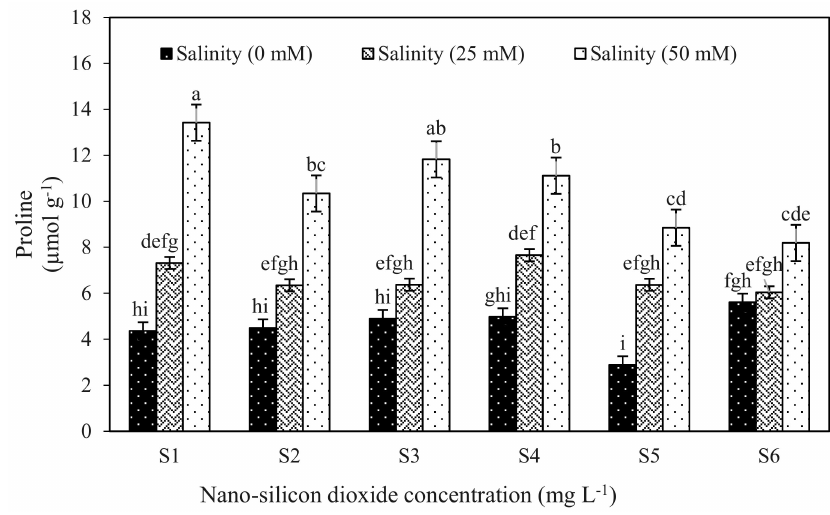
Figure 1. Proline concentrations of strawberry leaves from plants grown in three levels of salinity 0 mM (black bars), 25 mM (grey bars) and 50 mM (white bars) and treated with di ff erent levels of nano-silicon dioxide. Mean values with the same letters are not significantly di ff erent by least significant di ff erences (LSD) test at p ≤ 0.01. The content of photosynthetic pigments such as chlorophylls and carotenoids was significantly reduced in salt stressed plants relative to controls (no NaCl), especially for the 50 mM NaCl treatment where there was a 21% decrease in the total chlorophyll. Photosynthetic pigment content, including chlorophyll a, decreased in response to the salinity stress treatments and in contrast, the chlorophyll b and carotenoid content increased in response to the mild salinity level, but under the more severe 50 mM NaCl stress these pigments were reduced in comparison to controls (no NaCl). The treatments with nSiO 2 increased chlorophyll a, b and total chlorophyll and carotenoid content compared to controls (no nSiO 2 ) under stress and non-stress condition (Table 5).